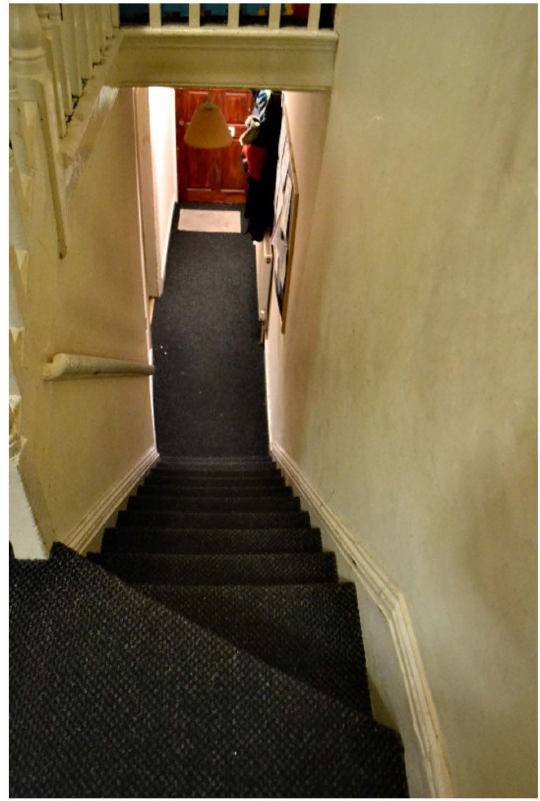
Figure 28. House